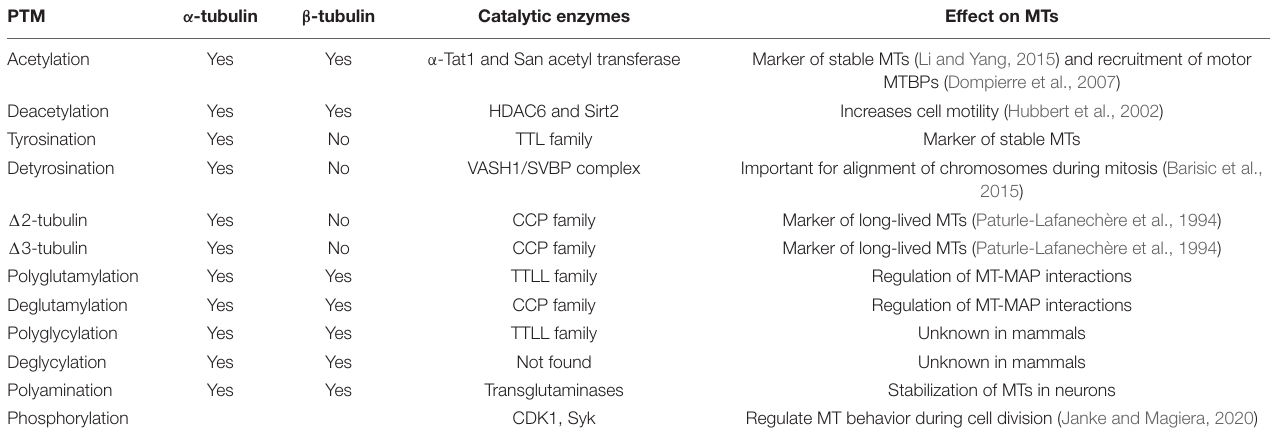
TABLE 3 | Summary of main PTMs, the catalytic enzymes taking part in the reaction and the effects of PTMs on MTs/cells. PTM α